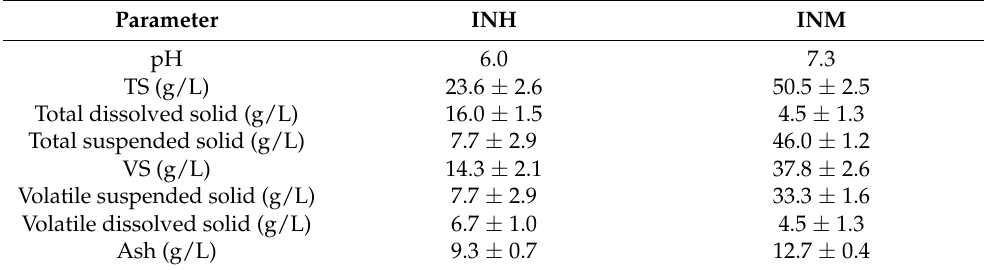
Table 2. INH and INM